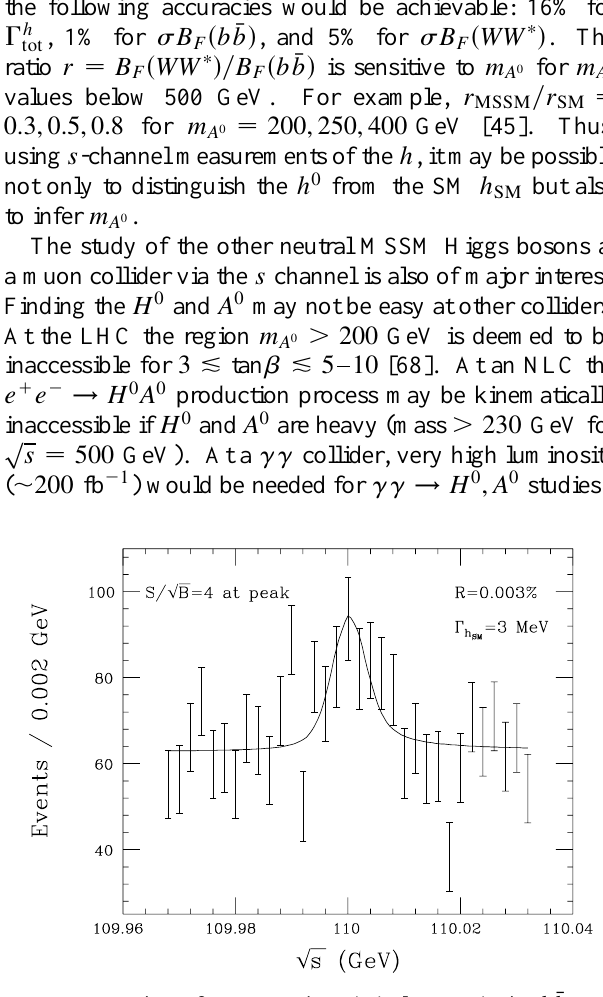
FIG. 7. Number of events and statistical errors in the b ¯ b final p (cid:1) 110 GeV, s in the vicinity of m h states as a function of SM assuming R (cid:1) 0.003% . From Ref.